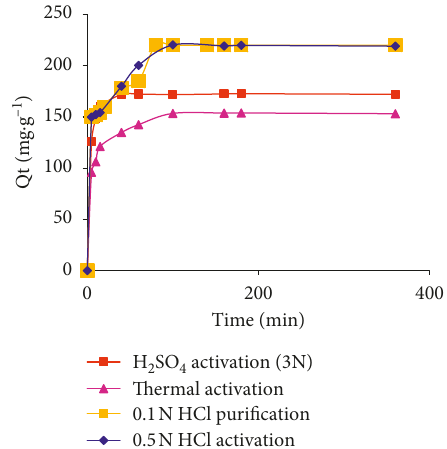
Figure 8: Adsorption capacities of clays activated with T � 900 ° C and acid in the presence of an initial solution of 750mg · L − 1 MG. The adsorption capacity of HCl purified clay was kept as reference.